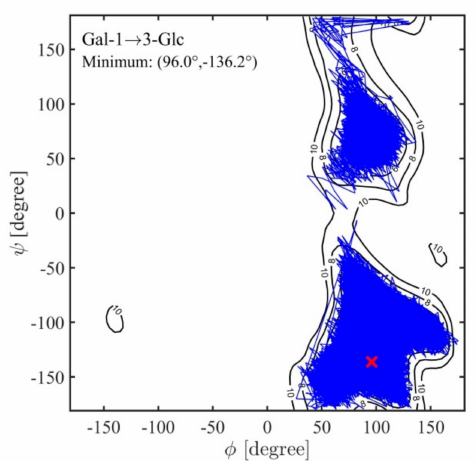
Figure 7. An example of a 1 µ s molecular dynamics (MD) trajectory on top of the calculated fully relaxed Ramachandran conformational energy map for the disaccharide α -D-Gal p -(1 → 3)- α -D-Glc p whose original energy map is shown in Figure 5 top left.